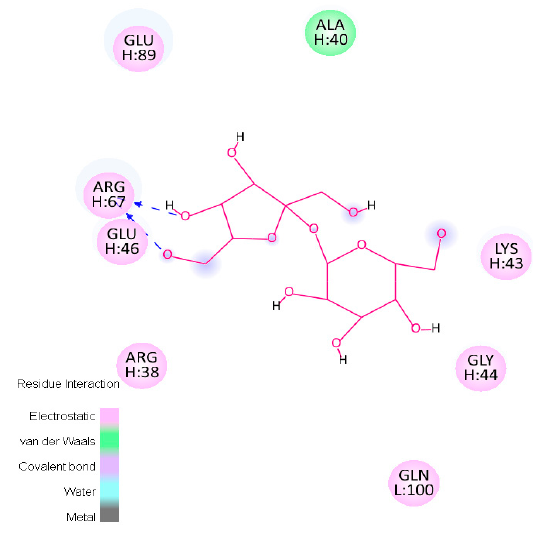
Figure 9. Example of the interaction framework plotted—in this case, sorbitol.